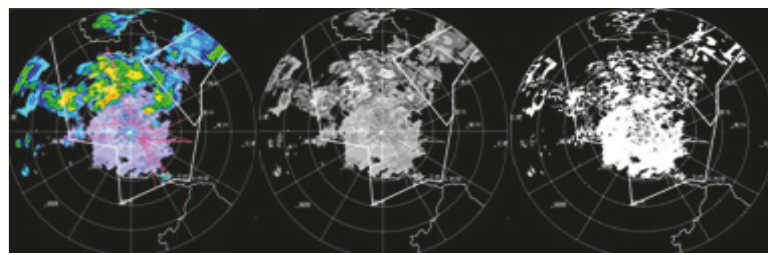
Figure 1: Transforming a color picture into a binary